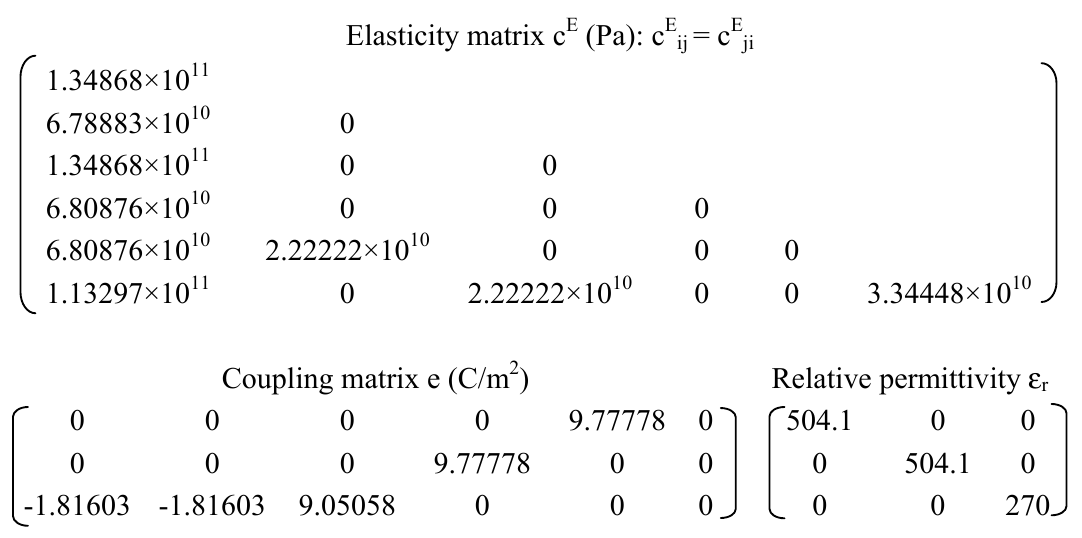
Table 1. The material properties of AT-cut quartz crystal in simulation.